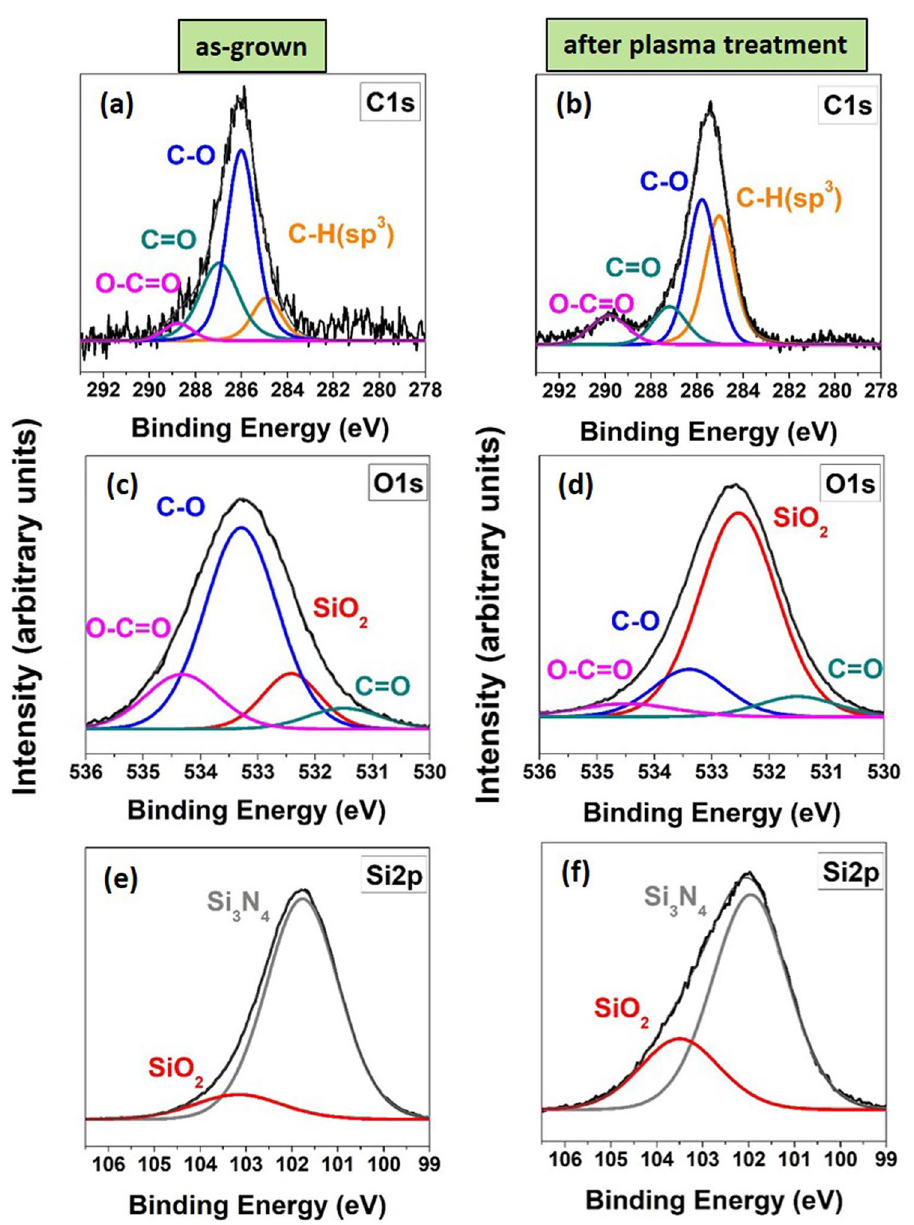
Figure 3. The characteristic XPS spectra of PE-Si 3 N 4 surface ( a ) C 1s spectra for as-grown , ( b ) C 1s spectra for plasma treated, ( c ) O 1 s spectra for as-grown, ( d ) O 1s spectra for plasma treated , ( e ) Si 2p spectra for as-grown ( f ) Si 2p spectra for plasma